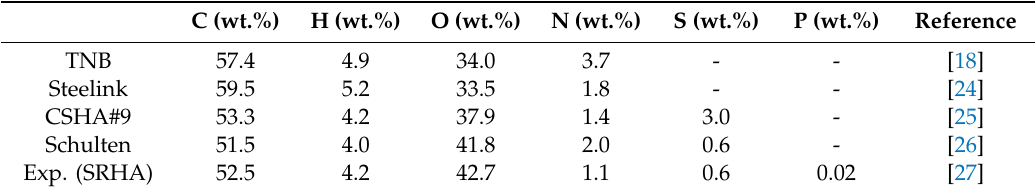
Figure 1. Molecular structure of the Temple-Northeastern-Birmingham (TNB) model: ( a ) the structural formula of the TNB model; ( b ) the morphology of TNB model in simulation software. C (gray), O (red), H (yellow), N (blue). Table 1. Experimental data of several humic acid (HA) molecular